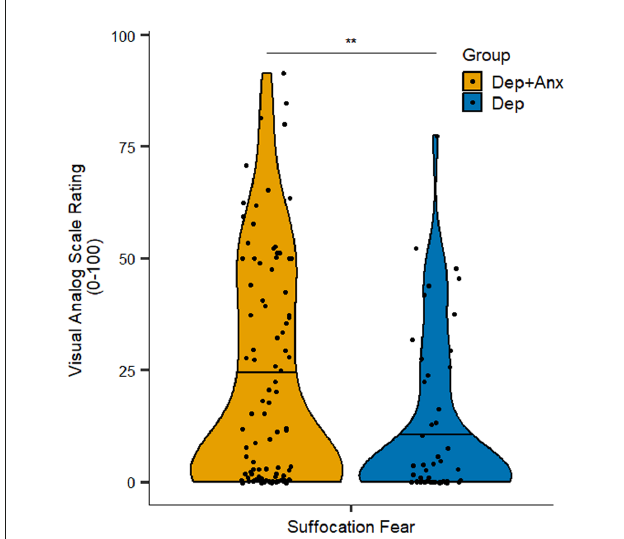
FIGURE1 Self-report ratings of suffocation fear in the Breath-Hold Task. Note that the Dep+Anx group reported significantly higher suffocation fear than the Dep group. Violin plots visualize distribution of the data, horizontal line represents the median. Dep+Anx, comorbid depression and anxiety disorders; Dep, depression only. ** p <